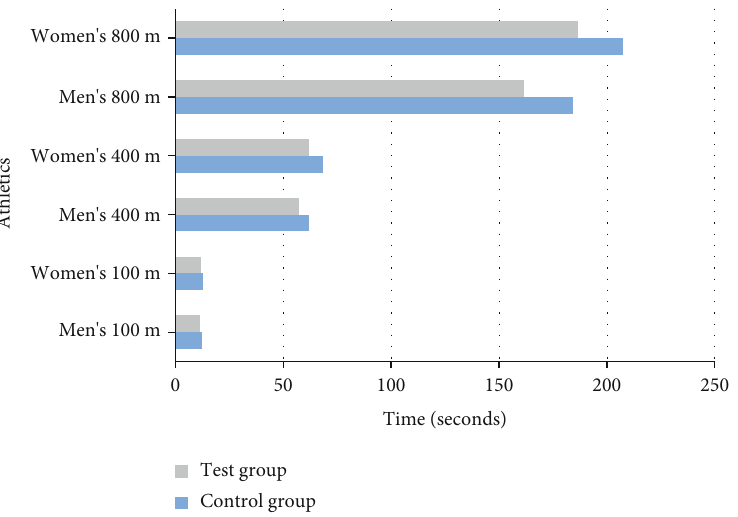
Figure 4: Training results of some track and fi eld